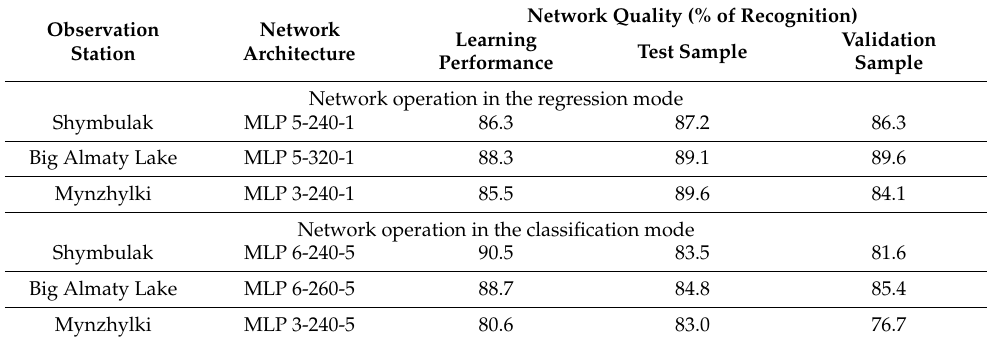
Table 6. Results of training and testing the neural network simulator from StatSoft to assess the avalanche danger